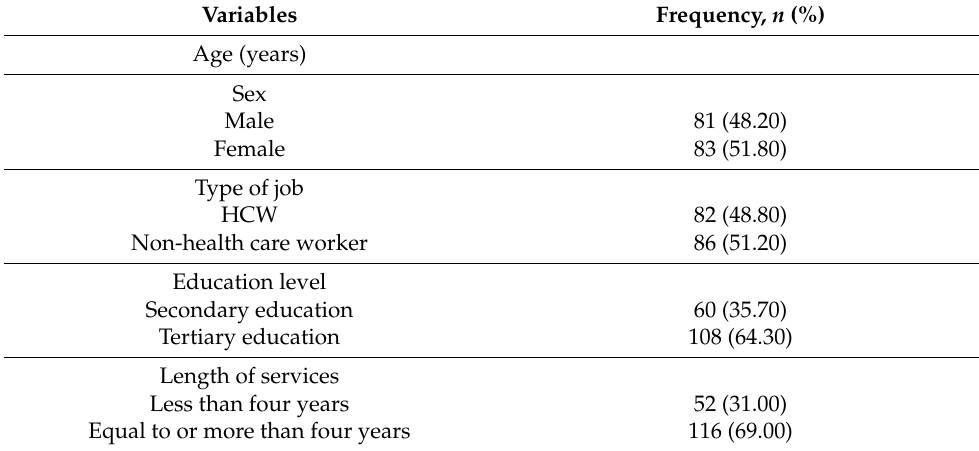
Table 1. Respondent